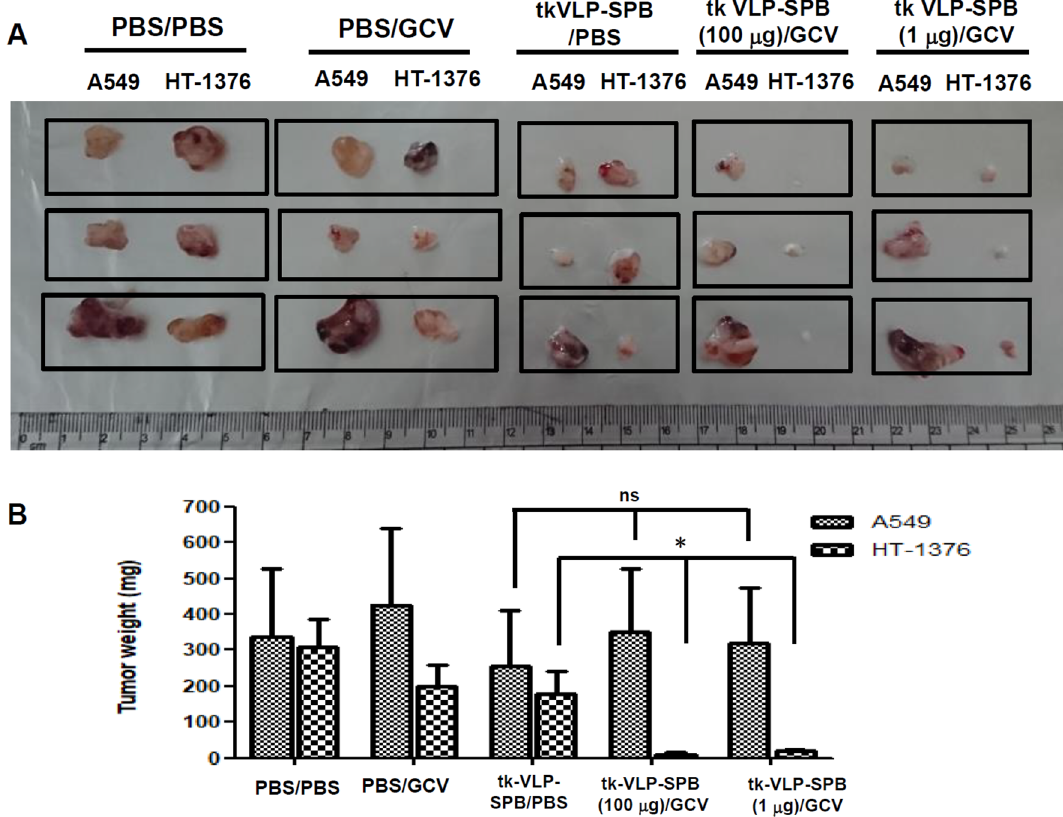
Figure 5. Specific inhibition of bladder cancer growth by tk-JCPyV VLP-SPBs in a xenograft mouse model. Mice were injected with A549 and HT-1376 cells in the left and right dorsal regions, respectively. The mice were divided into five groups and injected with PBS (PBS/PBS), GCV (PBS/GCV), tk-JCPyV VLP-SPB/PBS, tk-JCPyV VLP-SPB (100 μg)/GCV, or tk-JCPyV VLP-SPB (1 μg)/GCV. JCPyV VLP-SPB was injected into the tail vein, and GCV was administered by intraperitoneal injection. Injections were given once every three days for a total of 12 injections. Mice were anesthetized and euthanized with isoflurane, and the tumors were collected and weighed. ( A ) Photographs of tumors in the five groups. ( B ) Tumor weights in the five groups. *: P < 0.05 was considered statistically significant and is indicated by an asterisk (*). ns: not